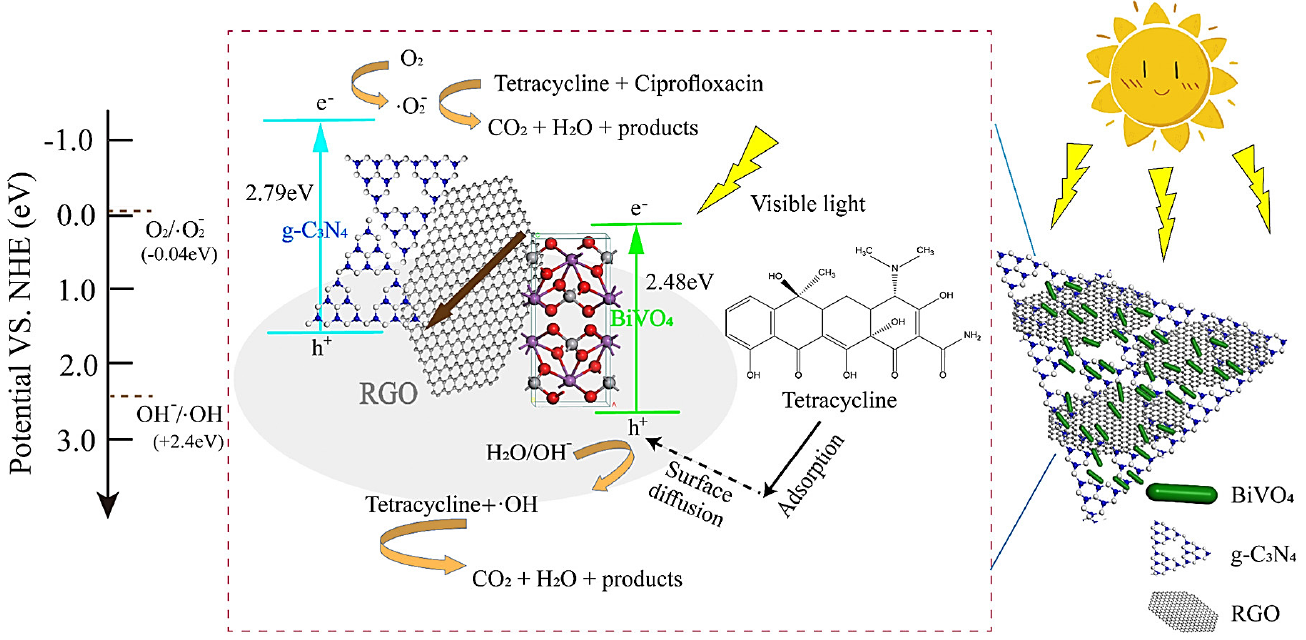
Figure 3. The proposed mechanism for antibiotic photodegradation (tetracycline and ciprofloxacin) using BiVO 4 /reduced graphene oxide (RGO)/g-C 3 N 4 Z-scheme photocatalysts. Adapted from [73] with permission. Copyright 2022 Elsevier.